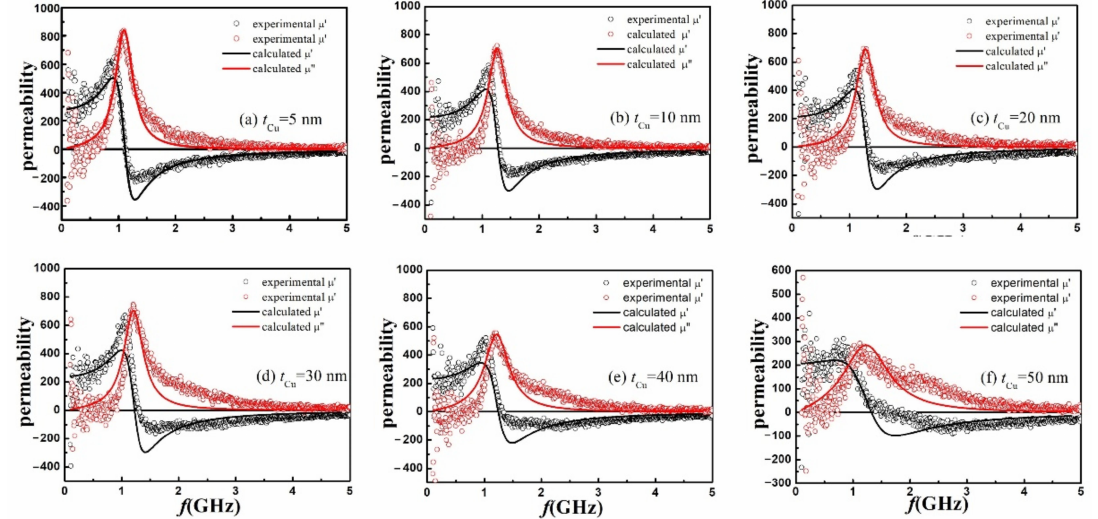
Figure 4. The permeability spectrum of the real µ ’ and imaginary µ ” components of the permeability of the samples with t Cu increasing from 5 nm to 50 nm. The solid line is the fitting curve with the LLG